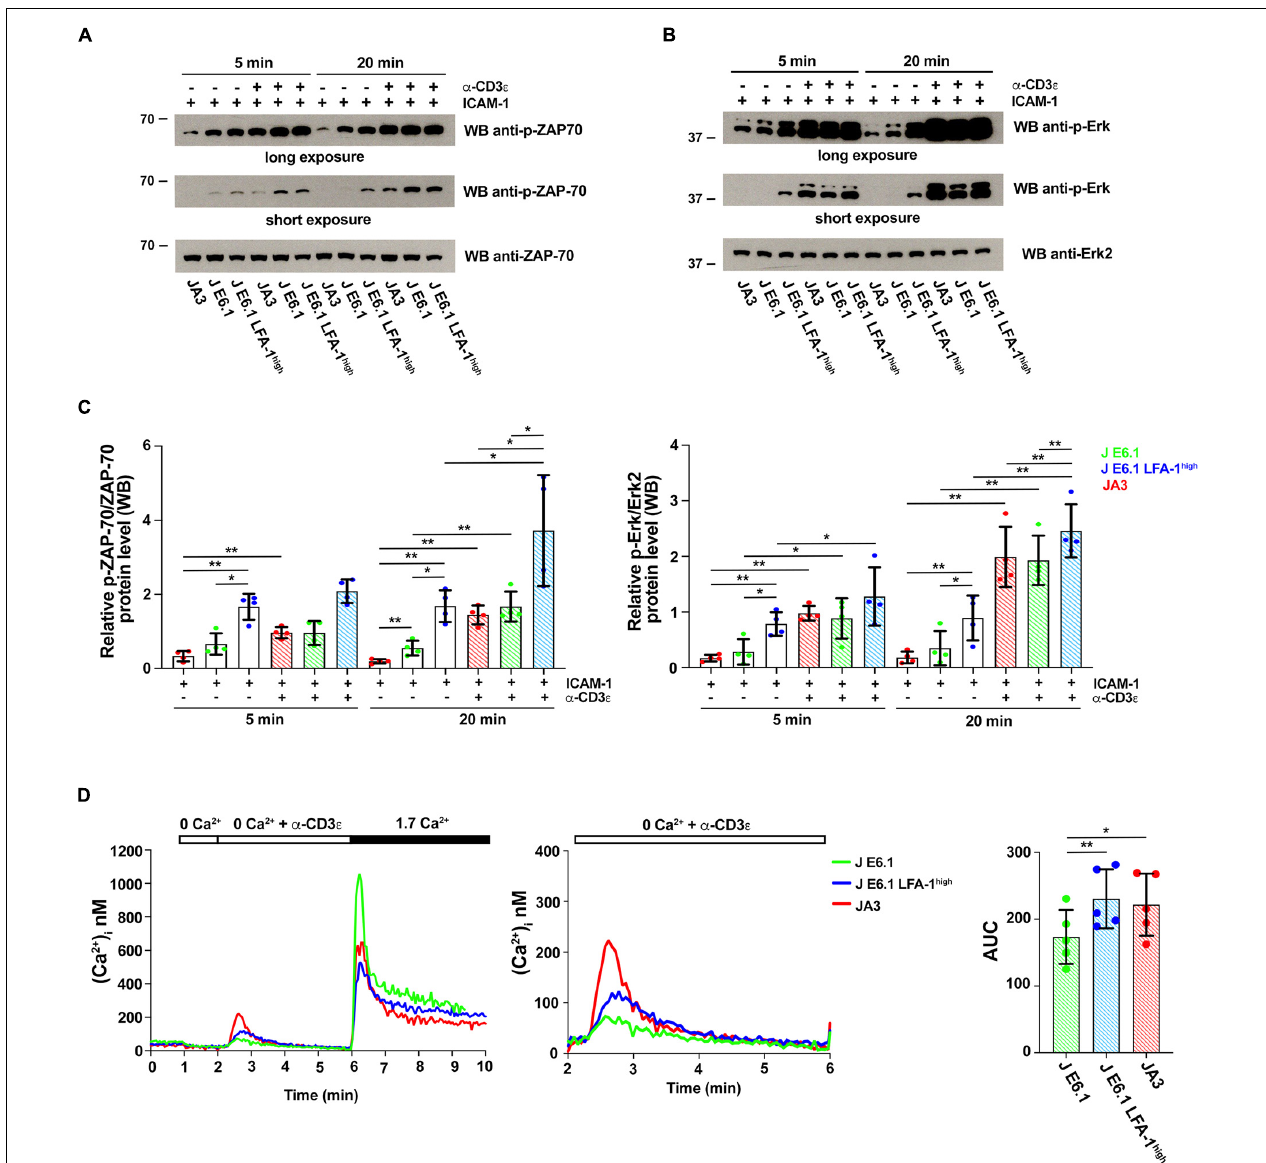
FIGURE 4 | Increasing LFA-1 expression in E6.1 cells affects early signaling events. (A,B) Immunoblot analysis with anti-p-ZAP-70 (A) or anti-p-Erk1/2 (B) antibodies of lysates from E6.1, E6.1 LFA-1 high or JA3 Jurkat cells plated on glass-immobilized ICAM-1 in the presence or absence of anti-CD3 ε mAb, clone OKT3 for 5 or 20 min. Anti-ZAP-70 and anti-Erk2 antibodies were used as respective loading controls. Representative blots are shown. The migration of molecular mass markers is indicated. (C) Quantification of the relative levels of p-ZAP-70 and p-Erk1/2, normalized to the respective loading control (mean ± SD; paired Student’s t -test; n = 4). Only significant differences are shown. * p < 0.05; ** p < 0.01. (D) [Ca 2 + ] i mobilization in Fura-2/AM-loaded Jurkat cells. Cells were stimulated with anti-CD3 ε mAb, clone OKT3 followed by anti-mouse IgG in Ca 2 + -free buffer to evaluate Ca 2 + release followed by re-addition of 1.7 mM Ca 2 + to evoke Ca 2 + influx (left); a magnification of anti-CD3 ε mAb (clone OKT3) + anti-mouse IgG-induced Ca 2 + release is shown on the right. The histogram shows AUC values to quantify anti-CD3 ε mAb-induced Ca 2 + release (mean ± SD; paired Student’s t -test; n = 5). Only significant differences are shown. * p < 0.05; ** p < 0.01.